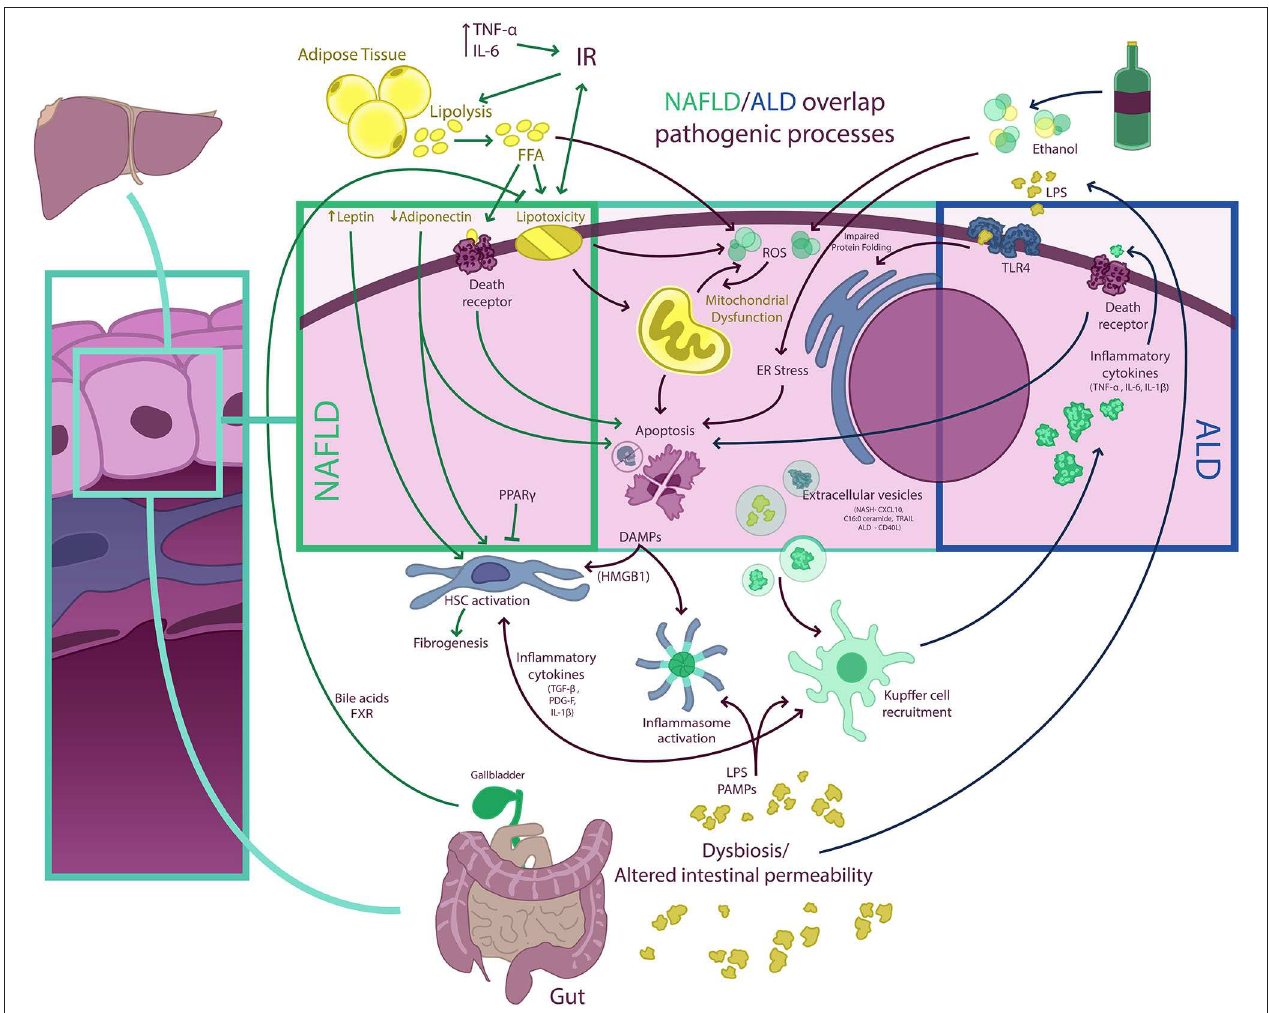
FIGURE 3 | NAFLD/ALD overlapping pathogenic processes. Free fatty acids (FFA) and ethanol have a myriad of effects on hepatocytes determining, among other phenomena, the occurrence of mitochondrial dysfunction, endoplasmic reticulum (ER) stress (resulting in impaired protein folding), and excessive production of ROS, which result in hepatocellular injury, activation of other cell death pathways, and inflammasome activation. Damaged hepatocytes release damage-associated molecular pattern (DAMP) molecules [e.g., high-mobility group box 1 (HMGB1)] that signal to Kupffer and hepatic stellate cells (HSC), fueling inflammation and fibrogenesis. Extracellular vesicle (EV) release from hepatocytes also contributes to both Kupffer cell and HSC activation. In non-alcoholic fatty liver disease (NAFLD), insulin resistance (IR) is a central phenomenon promoting adipose tissue lipolysis and an increased FFA flux to the liver. This FFA overflow surpasses the storage capacity of hepatocytes and determines the occurrence of lipotoxicity and activation of cell death pathways. Also, adipose tissue dysfunction is associated with a proinflammatory state with elevated levels of circulating cytokines [e.g., tumor necrosis factor- α (TNF- α ) and interleukin (IL)-6] and with an imbalance in circulating levels of adipose tissue-derived adipokines (i.e., a decrease in adiponectin and an increase in leptin). This may increase IR and contribute to HSC activation. Of note, some nuclear receptors such as peroxisome proliferator-activated receptors (PPARs) and farnesoid X receptor (FXR), a bile acid receptor, may have anti-inflammatory and anti-steatotic effects, which are being exploited therapeutically. Both NAFLD and ALD (alcohol-related liver disease) are associated with intestinal dysbiosis and altered gut permeability, which results in the pass of bacterial products [e.g., pathogen-associated molecular patterns (PAMPs), lipopolysaccharides (LPS), and others] into portal circulation. In the liver, LPS and PAMPS may activate different Toll-like receptors (TLRs) as well as promote inflammasome assembly determining amplification of inflammatory responses. In ALD, proinflammatory cytokines released from macrophages may also activate cell death receptors and induce